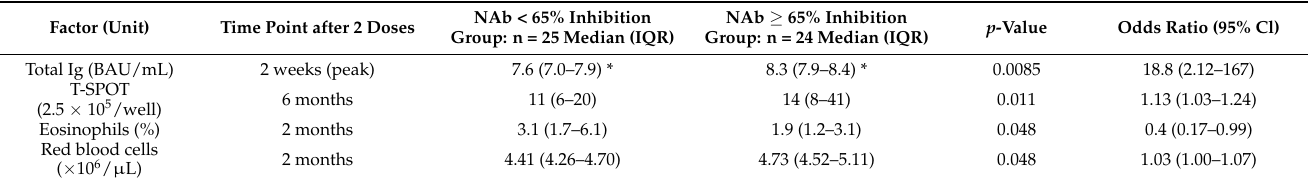
Table 2. Associations between levels of neutralizing antibodies at two weeks after the booster dose and results of clinical laboratory tests and immune parameters at all time points after two